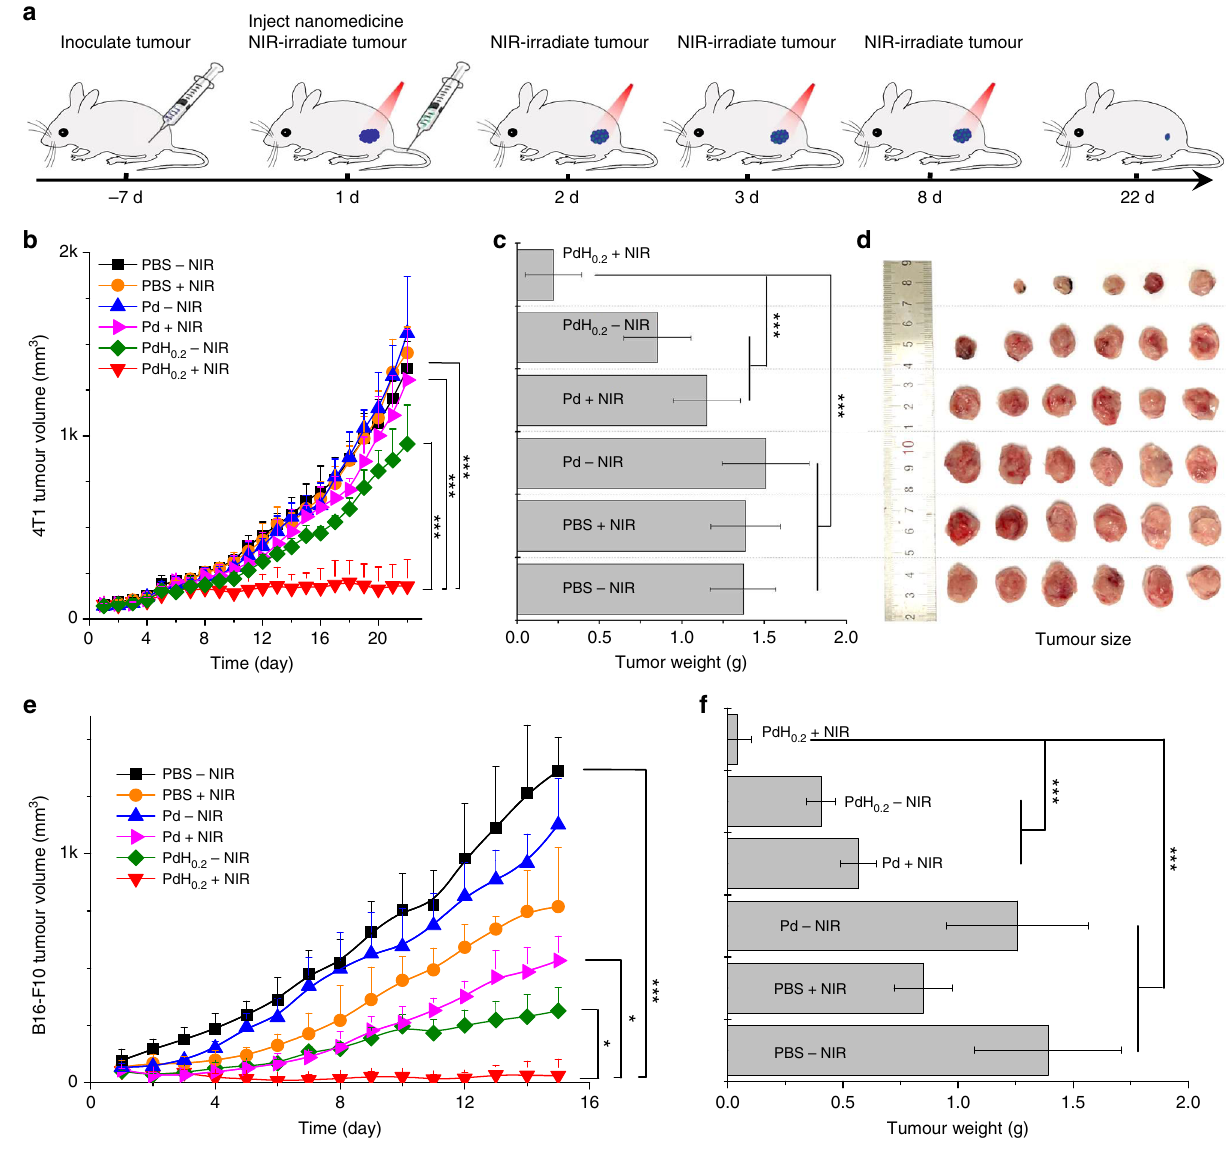
Fig. 6 In vitro and in vivo therapy ef fi cacies of PdH 0.2 nanocrystals. a Tumour-bearing mice therapy approach. b 4T1 tumour volume change during treatment. c 4T1 tumour weight comparison after 22-day treatment. d Digital images of corresponding 4T1 tumours ( n = 6). e B16-F10 tumour volume change during treatment. f B16-F10 tumour weight comparison after 15-day treatment ( n = 6). Mean value and error bar are de fi ned as mean and s.d., respectively. P values were calculated by two-tailed Student ’ s t -test ( ***P < 0.005, *P < 0.05) by comparing other groups with the PdH 0.2 + NIR